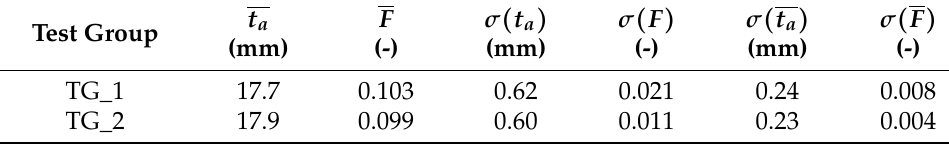
Table 7. Repeatability of flatness of initial